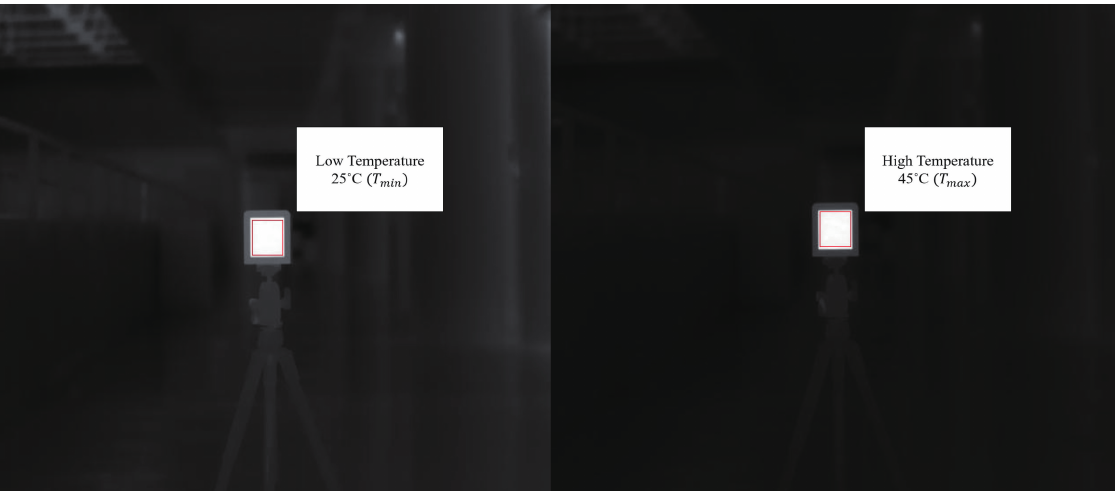
Figure 3. Blackbody T min , T max measurement.